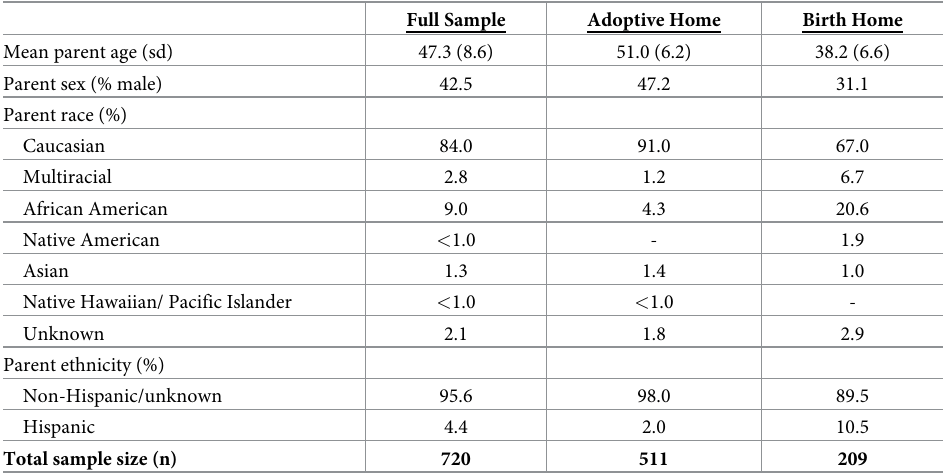
Table 2. Reporting parent descriptive statistics by home